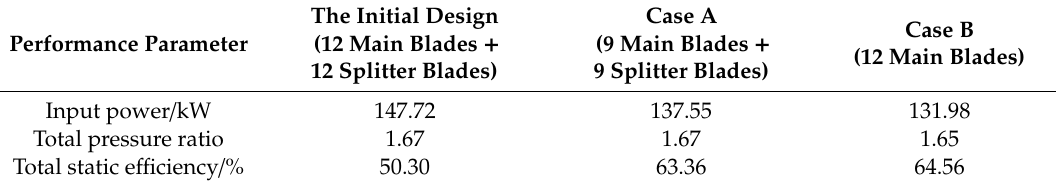
Table 5. Performance analysis of the initial design compressor.